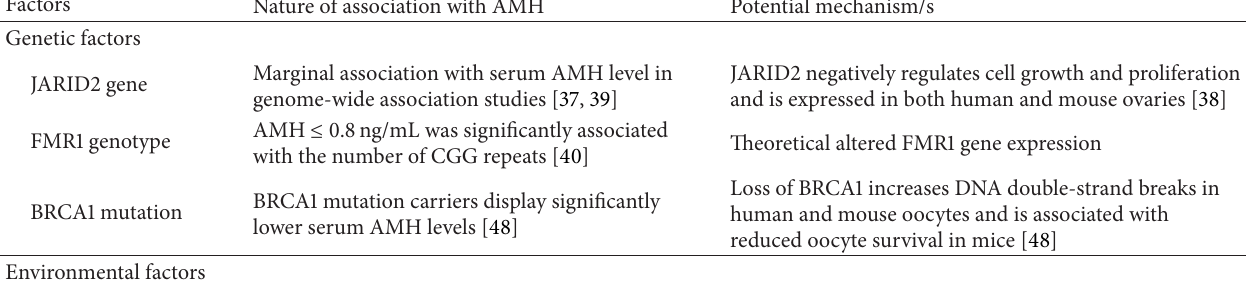
Table 1: Potential factors and associated mechanisms underlying racial/ethnic differences in serum antim¨ullerian hormone (AMH) levels.